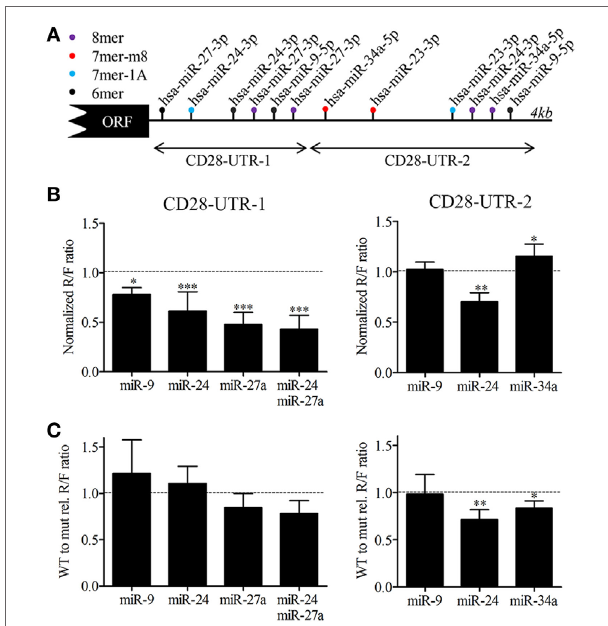
FigUre 5 | MicroRNAs (miRNAs) binding site analysis of the CD28 3 ′ UTR. (a) Schematic overview of the predicted miRNA binding sites for miR-9-5p, miR-34a-5p, and members of the miR-23a~miR-24-2 cluster in the 3 ′ UTR of CD28 (ENST00000324106.8). Binding sites were identified using the Targetscan prediction algorithm (release 7.1) in combination with a manual search for 6mers. The arrow indicates the two regions that were cloned in the luciferase reporter constructs. 8mer: exact match to positions 2–8 of the mature miRNA followed by an A, 7mer-m8: exact match to positions 2–8 of the mature miRNA, 7mer-A1: exact match to positions 2–7 of the mature miRNA followed by an A and 6mer: exact match to positions 2–7 of